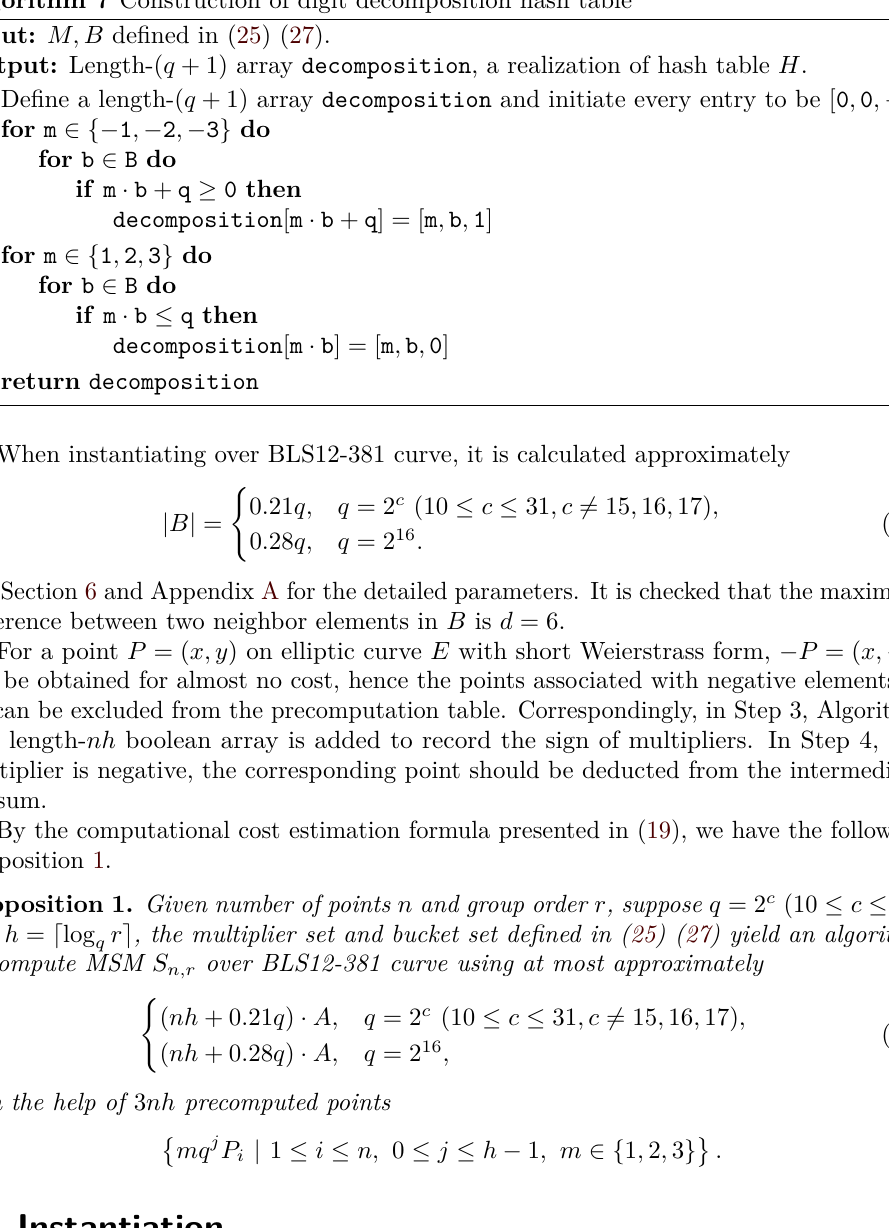
Algorithm 7 Construction of digit decomposition hash